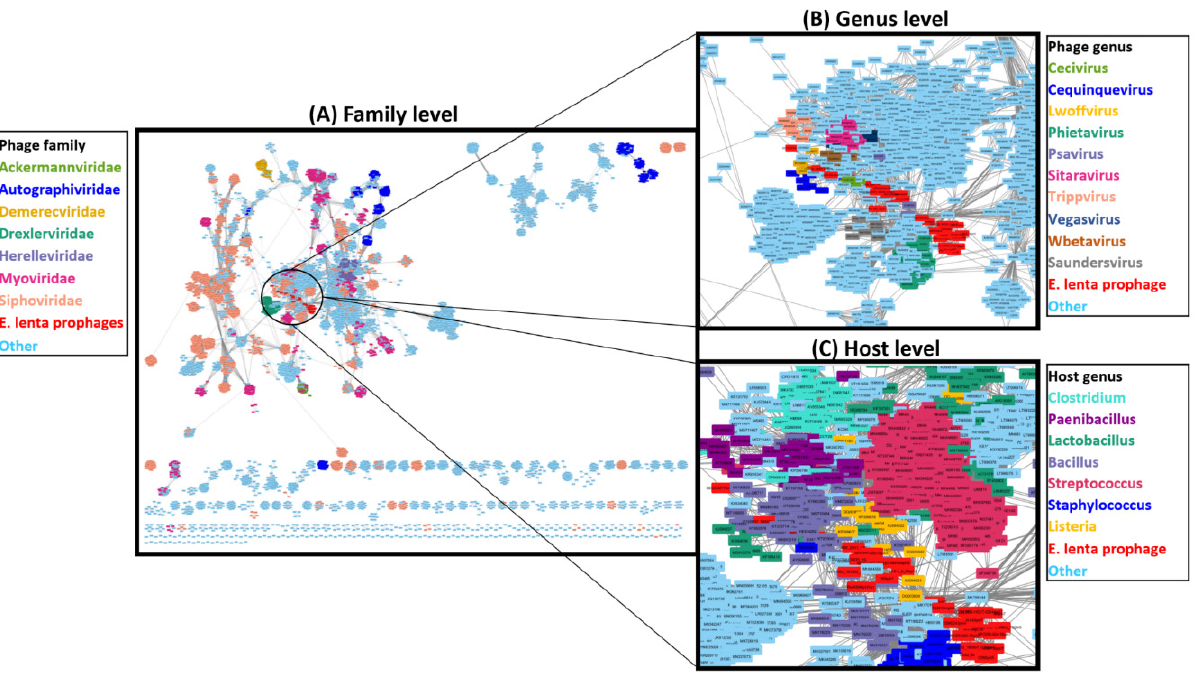
Figure 7. Network-based analysis of shared protein clusters with 33 E. lenta prophages with 12,892 phages visualised with Cytoscape. Each node represents a phage genome, lines (edges) represent the strength of connectivity (edge weight) between genomes. ( A ) Overview of network with nodes coloured to highlight family to which a phage belongs and a close-in view of the network of where E. lenta prophages are situated with nodes coloured to highlight ( B ) phage genus or ( C ) or host bacterium genus.